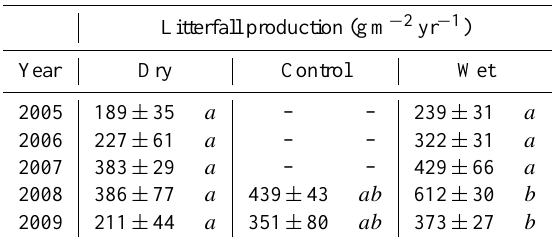
Table 3. Litterfall production (gm − 2 yr − 1 ) in the control, dry and wet treatments, for the five years of the throughfall manipulation experiment. Values are the means with ± 1 standard error ( n = 3). Within the same year, different letters indicate a significant differ- ence among treatments ( p < 0 . 05).